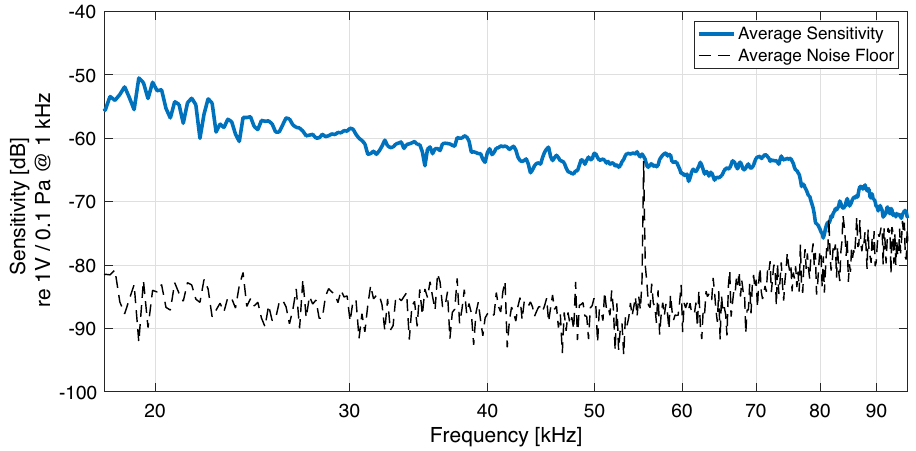
Figure 3. Average sensitivity and noise floor for the 6 sensors that were mounted on the spherical